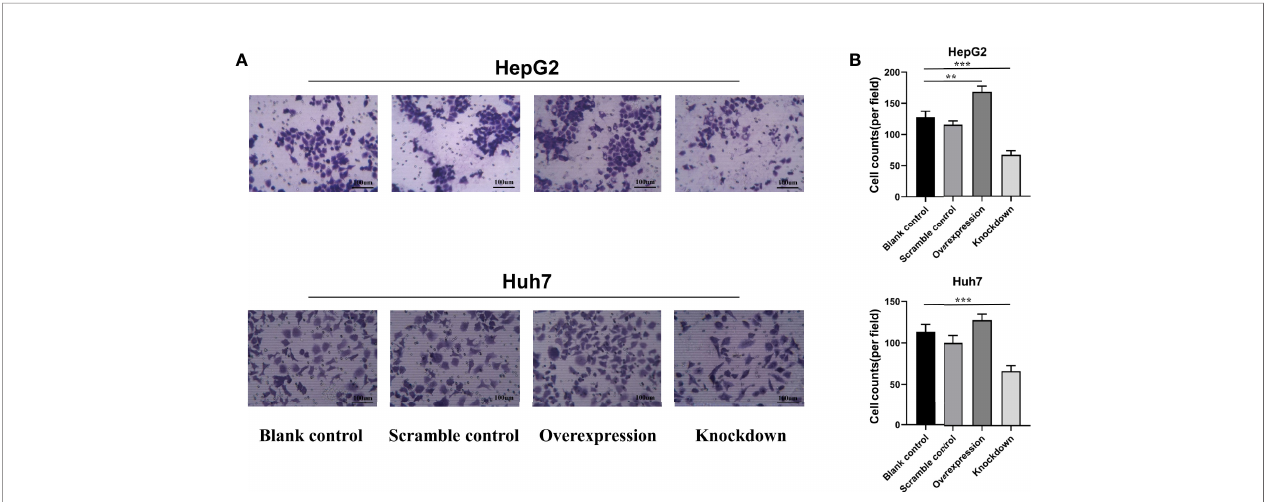
FIGURE 4 | Transwell ™ assay revealed effects of ASAP1-IT1 on cell migration in HepG2 and Huh7 cells. (A) Overexpression of ASAP1-IT1 promoted cell migration and down-regulation of ASAP1-IT1 inhibited cell migration in Huh7 and HepG2 cells compared with control groups. (B) Number of migrated cells per fi eld. Data were expressed as mean ± standard deviation (SD) of at least three independent experiments. **p < 0.01, ***p < 0.001 vs control groups.